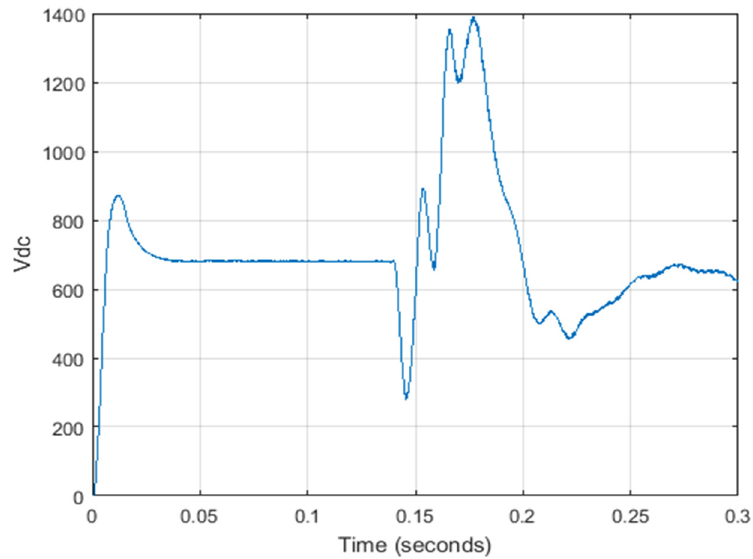
Figure 12. DC voltage in scenario 2.